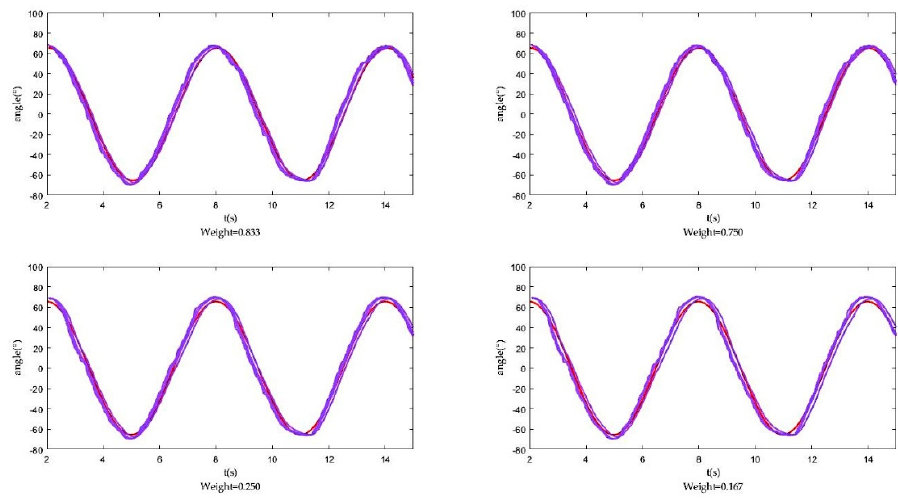
Figure 7. Fusion results of four groups with different weight.